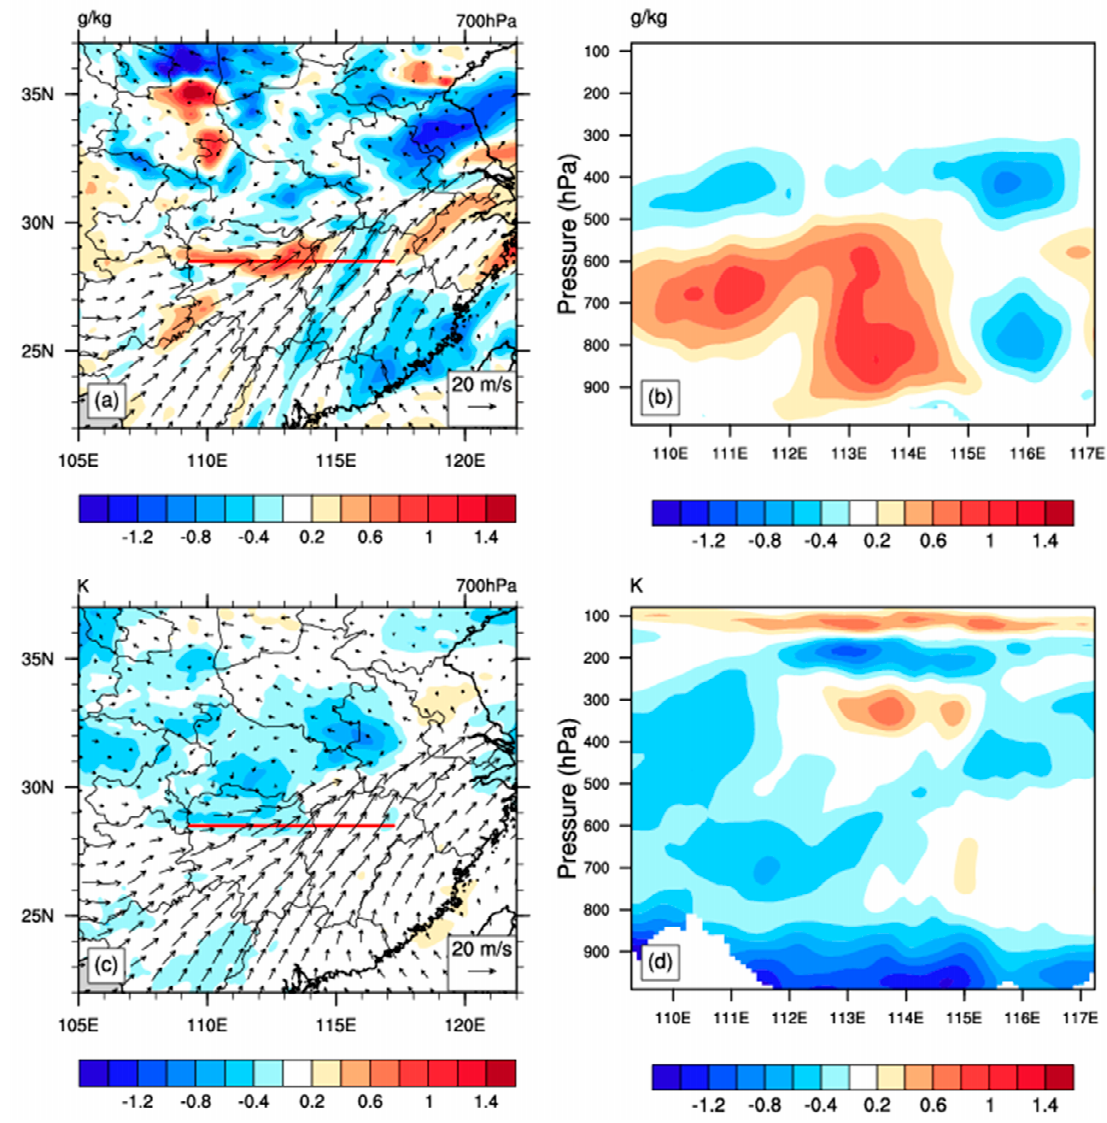
Figure 12. ( a ) The POD analysis increment of water vapor mixing ratio (shaded, g / kg) and analysis of horizontal wind (vectors) at 700 hPa at 0000 UTC 30 June. ( b ) The east-west cross-section of water vapor mixing ratio increments (shaded, g / kg) along the red line in ( a ); ( c , d ) are the same as above, but for temperature.